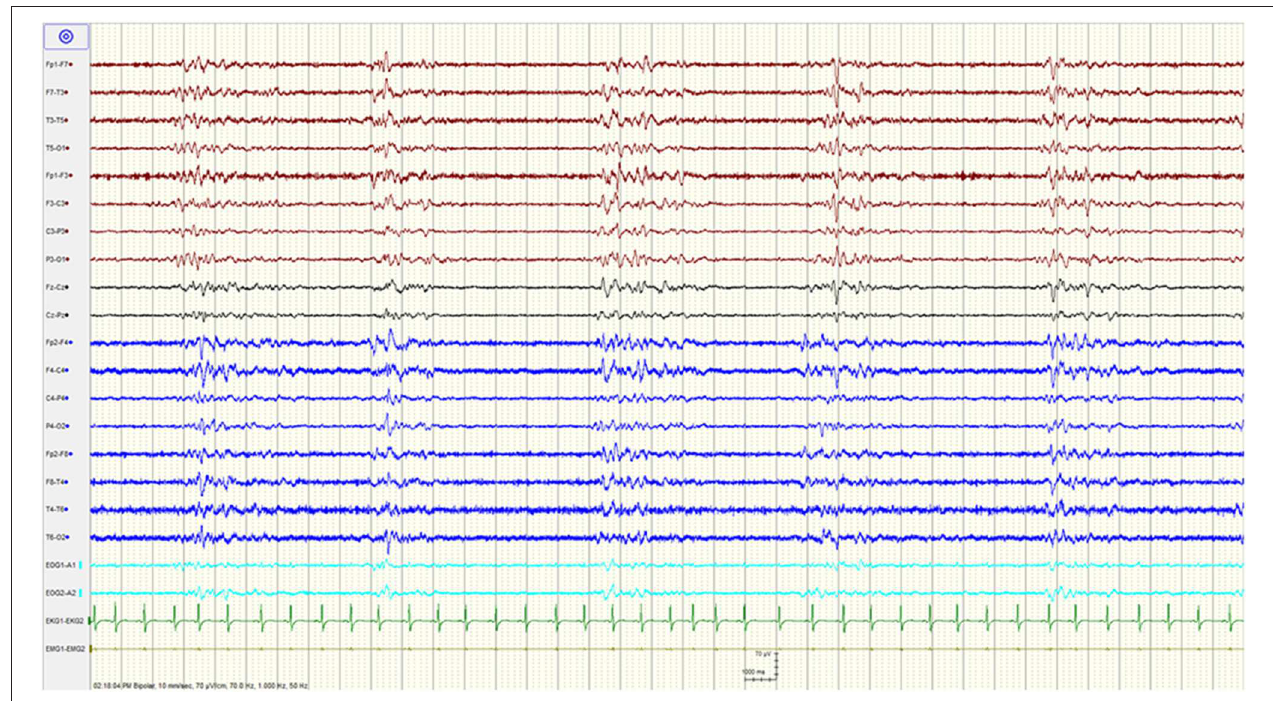
FIGURE 1 | Burst suppression pattern upon presentation to the Emergency department.